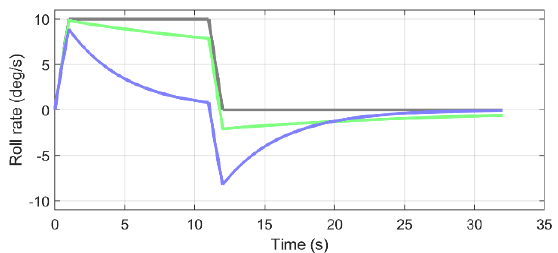
Figure 1. Model output of the SOMS model (blue line) and the Observer model (green line) in response to a sudden increase in roll rate (gray line) up to a constant rate followed by a deceleration back to zero. This shows that the semicircular canals respond to the onset of rotation (i.e., acceleration) and that this response subsides while rotation continues at a constant rate. As the response has waned, the deceleration at the stopping of the rotation causes an output below zero, which corresponds to a roll sensation in the opposite direction (i.e., the post-roll illusion).